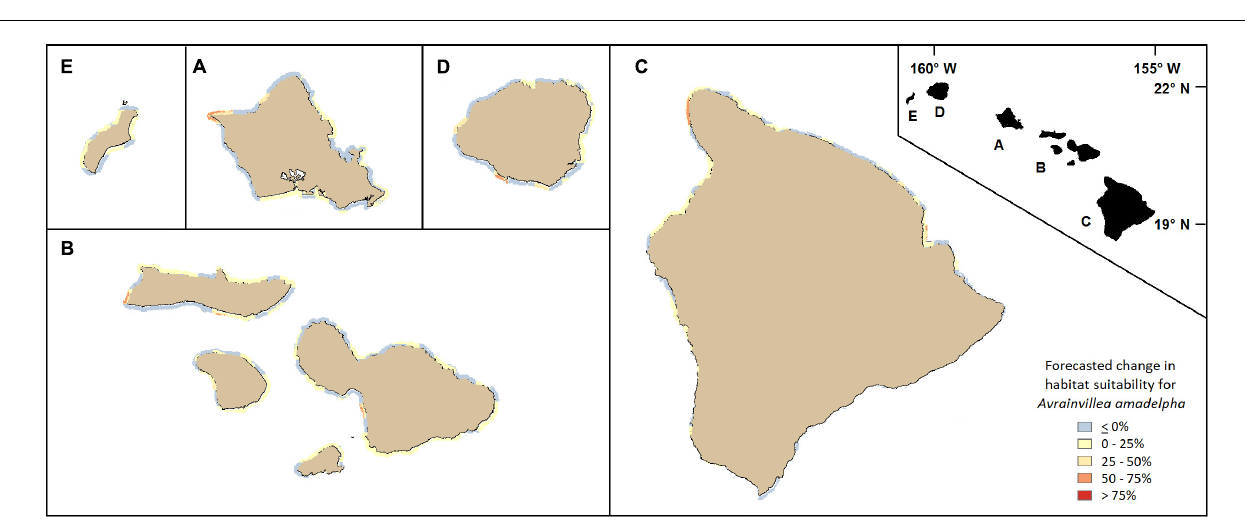
FIGURE 7 | Forecasted changes in habitat vulnerability subsequent to a theoretical 25% increase in maximum DHW across all coasts of the MHI ( A: Oahu, B: Maui Nui, C: Hawaii, D: Kauai, E: Niihau). Blue or yellow tones indicate slight decreases or no changes in susceptibility to invasion, while orange and red colors indicate increases in vulnerability compared to present day